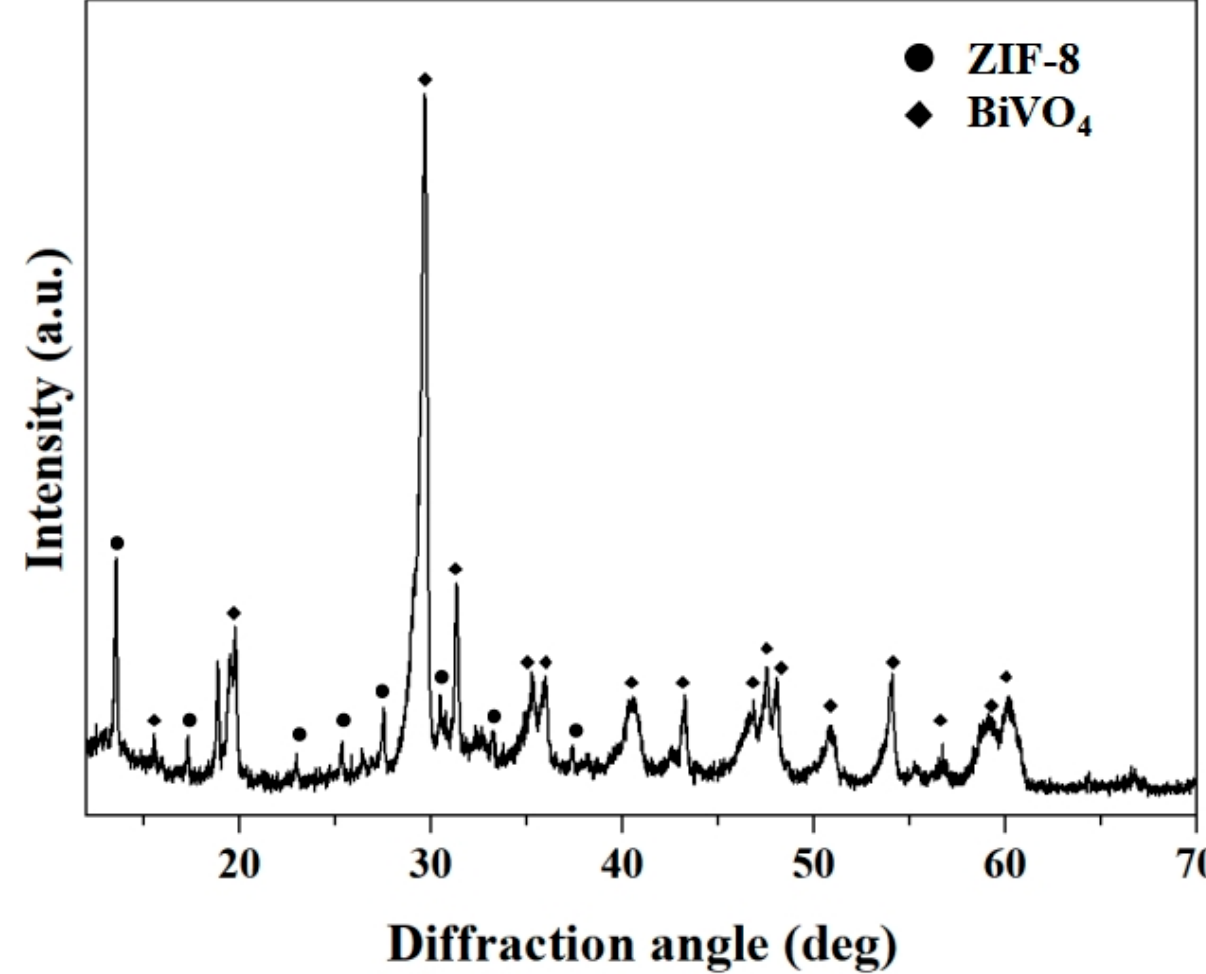
Figure 1. The XRD pattern of BiVO 4 @ZIF − 8. The diffraction peaks are assigned to BiVO 4 and ZIF − 8 as indicated. Morphologies of as-synthesized BiVO 4 nanorods and BiVO 4 @ZIF − 8 composites